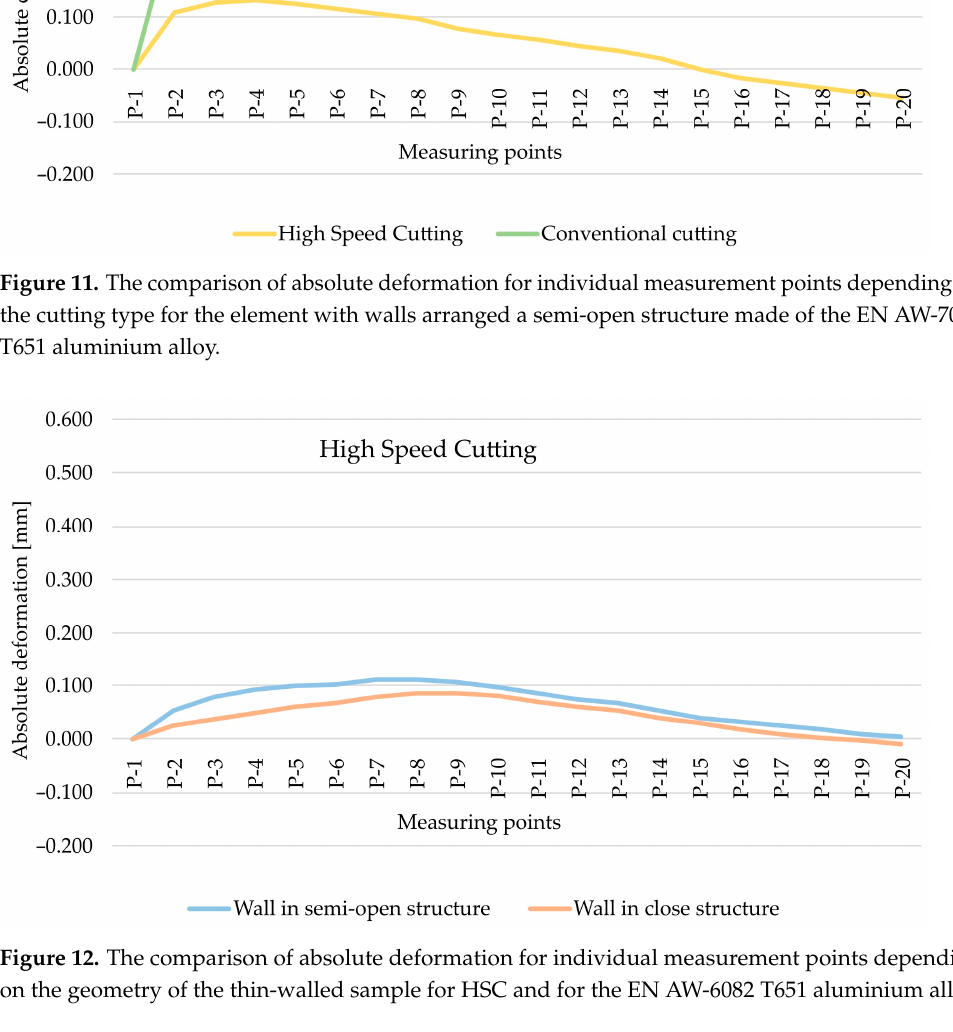
Figure 11. The comparison of absolute deformation for individual measurement points depending on the cutting type for the element with walls arranged a semi-open structure made of the EN AW- 7075 T651 aluminium alloy.